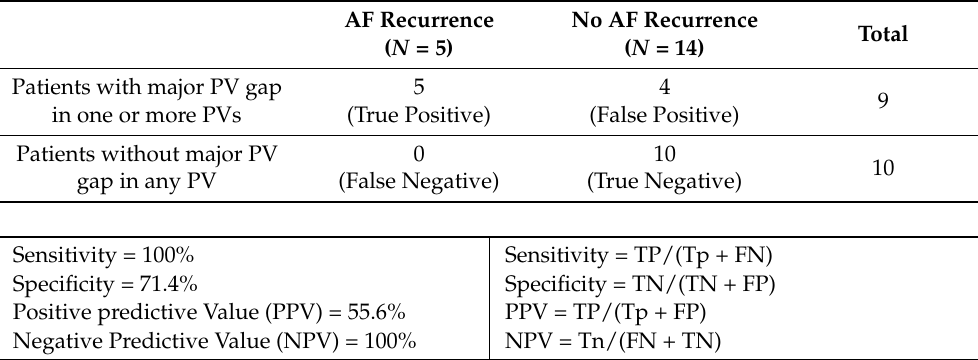
Figure 4. Kaplan–Meier (KM) survival without AF recurrence analysis according to presence or absence of major PV ostial gaps. The analysis shows absence of AF recurrence among the group without major PV gaps and a significant AF recurrence among the groups with major PV gaps. This KM analysis reinforces the significant correlation between presence of major PV ostial gaps and AF recurrence. Table 2. Sensitivity, specificity, and negative and positive prediction values of major PV gaps for AF recurrence after AF